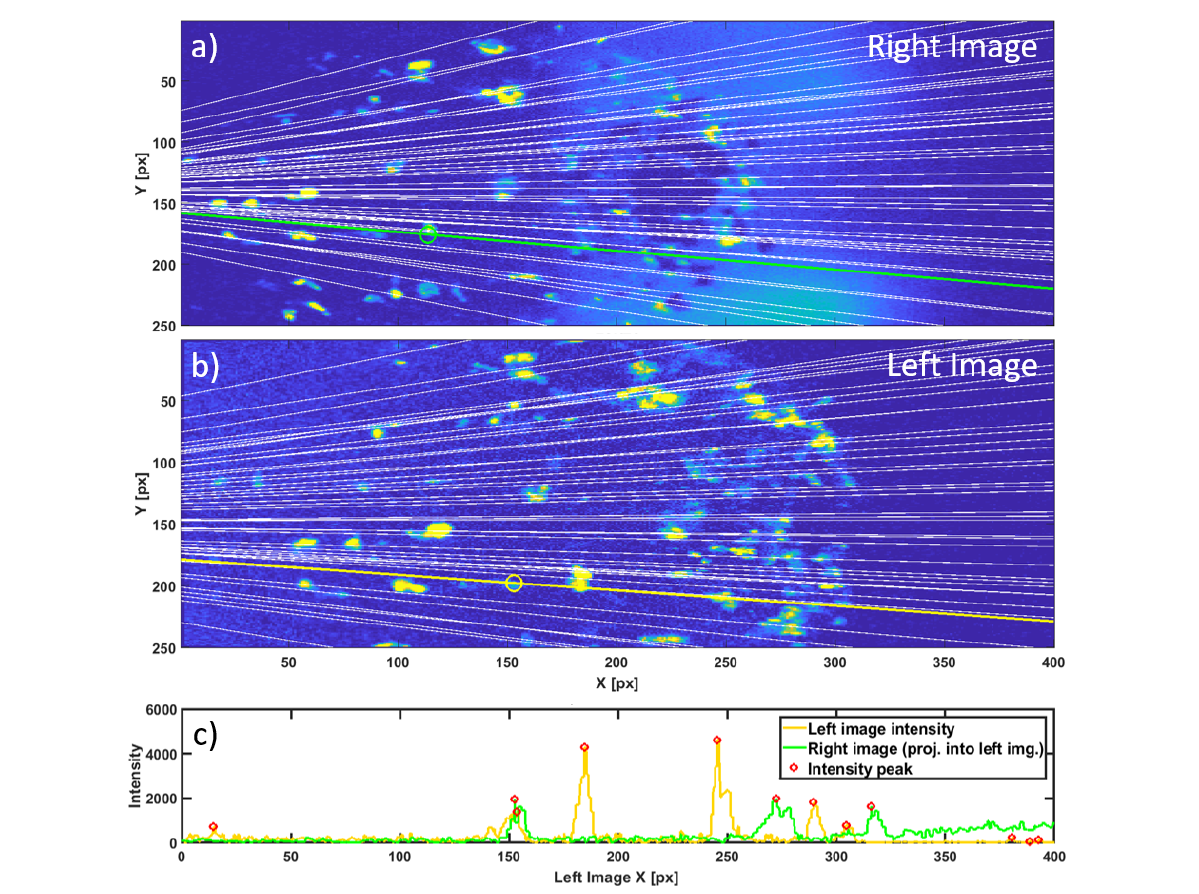
Figure 6. 3D trajectories shown in Fig. 5 are projected into the right (a) and left (b) camera images and shown as white lines. One trajectory is plotted as a yellow line in the left image (b). The pixel intensities along that trajectory are plotted in (c) as a yellow line. The same trajectory is plotted in green in the right image (a). Via epipolar geometry, intensities in the right image are plotted at their corresponding left image pixel location, allowing a direct comparison of intensities between left and right images (along the same 3D trajectory). Converging peaks represent the same fragment on the trajectory.